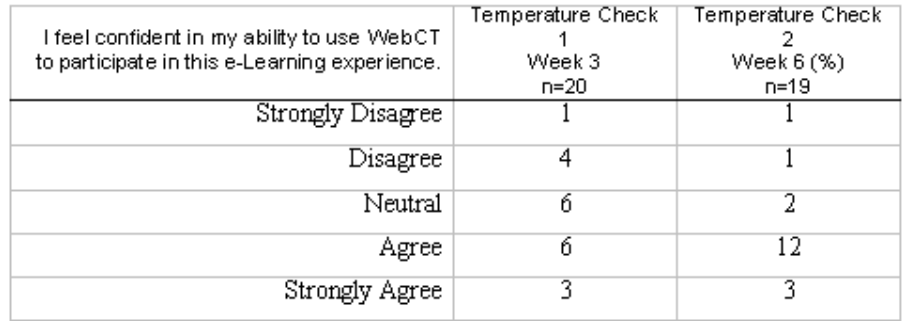
Table 1. Growing Confidence in the e-Learning